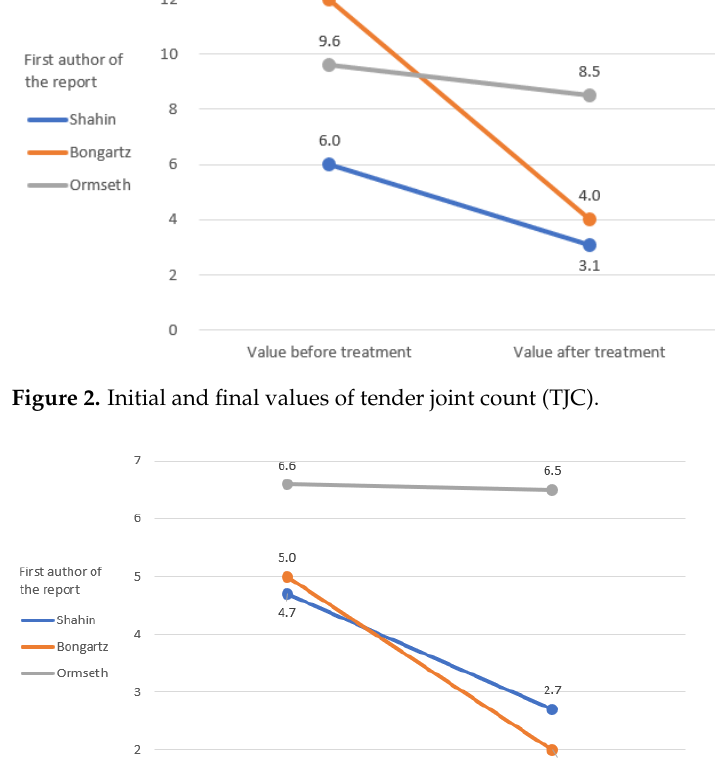
Figure 4. Initial and final values of C-reactive protein (CRP) [mg/L]. Figure 5. Initial and final values of erythrocyte sedimentation rate (ESR) [mm/h].